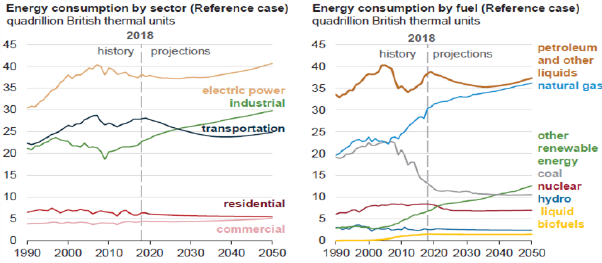
Fig. 1. Historical and projection models of energy and fuel consumption by economy sector in the USA